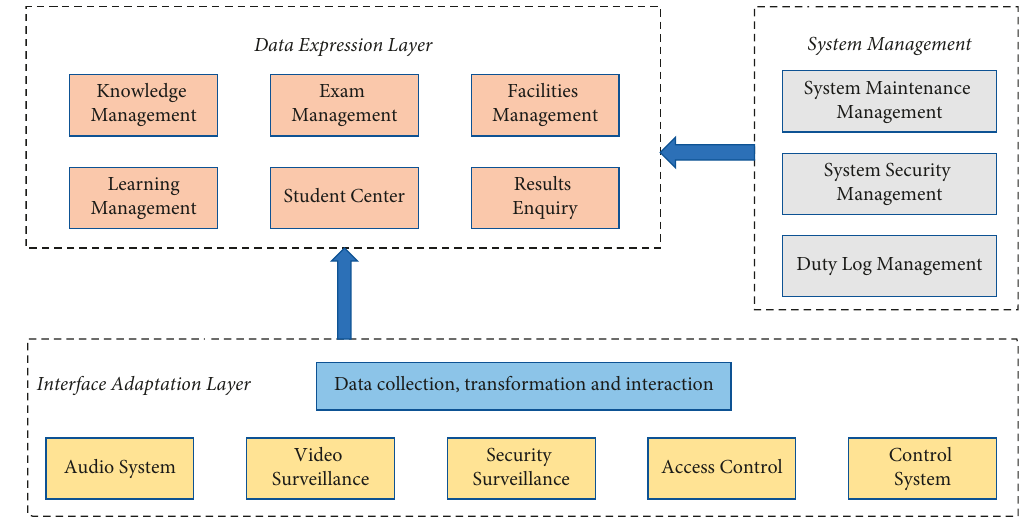
Figure 3: Structure of the software